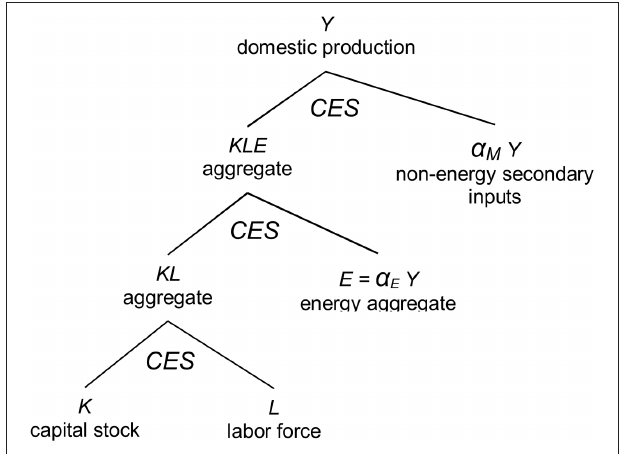
FIGURE 4 | Nested production structure in IMACLIM-S versions iterating to convergence with BU